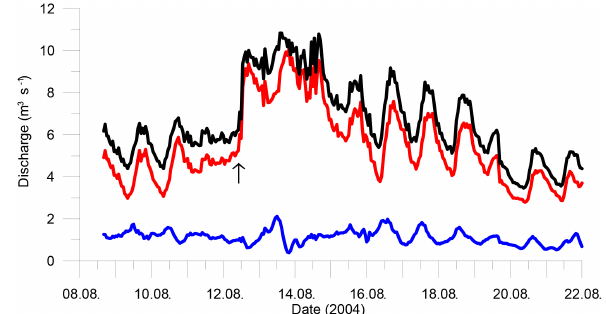
Figure 6. Hydrograph showing the separation of the discharge in the Mittivakkat Gletscher river (black curve) into an ice melt com- ponent (red curve) and a snowmelt component (blue curve) dur- ing the period 8–21 August 2004. The error of the ice melt and snowmelt components depends on the constant endmember esti- mates and the cubic spline interpolation. The arrow indicates the onset of the abrupt change in